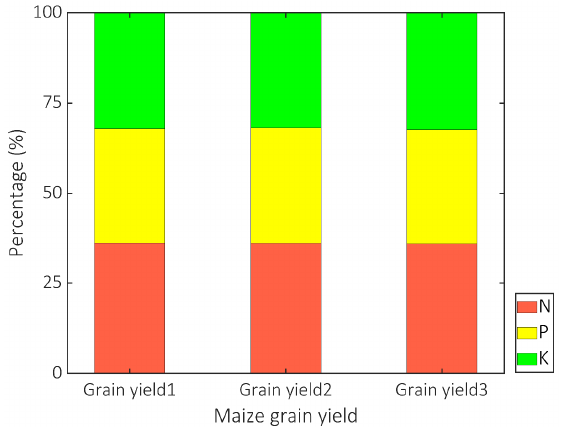
Figure 8. The grey relation coefficients (GRC) of N, P, and K for maize grain yields using grey relation analysis (GRA).